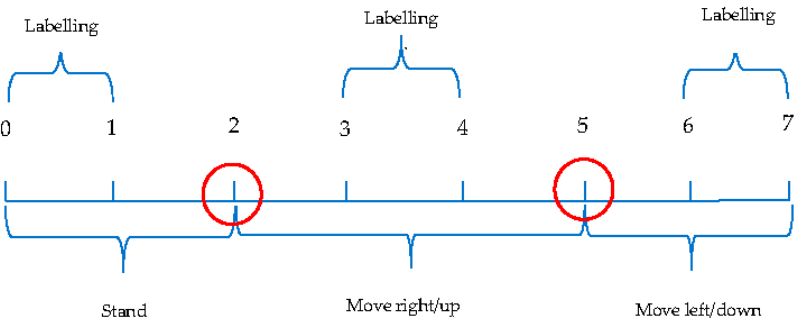
Figure 5. Graph demo of the experiment design.